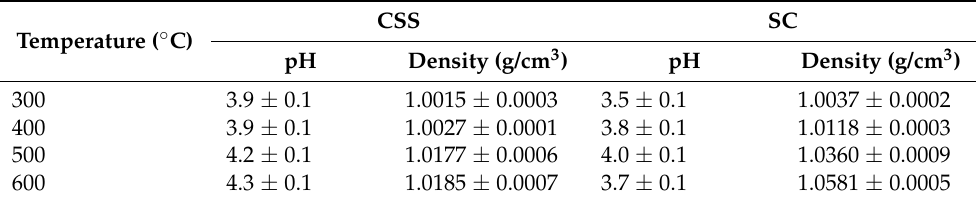
Table 4. Results of pH and density of liquid fractions at different pyrolysis temperatures for CSS and SC. CSS SC Temperature ( ◦ C) pH Density (g/cm 3 ) pH Density (g/cm 3 )